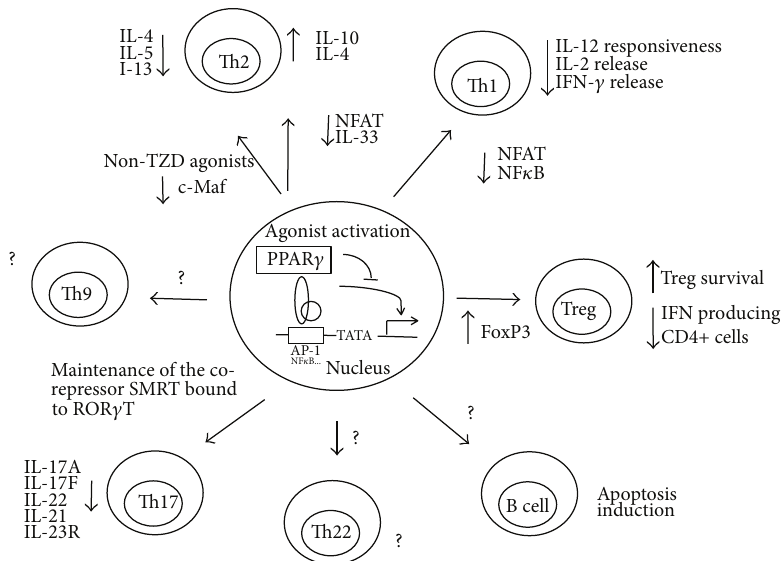
Figure 1: Effects of PPAR 𝛾 agonists on cytokine expression and on lymphocytes involved in adaptive immunity. ? Represents mechanisms that are not well